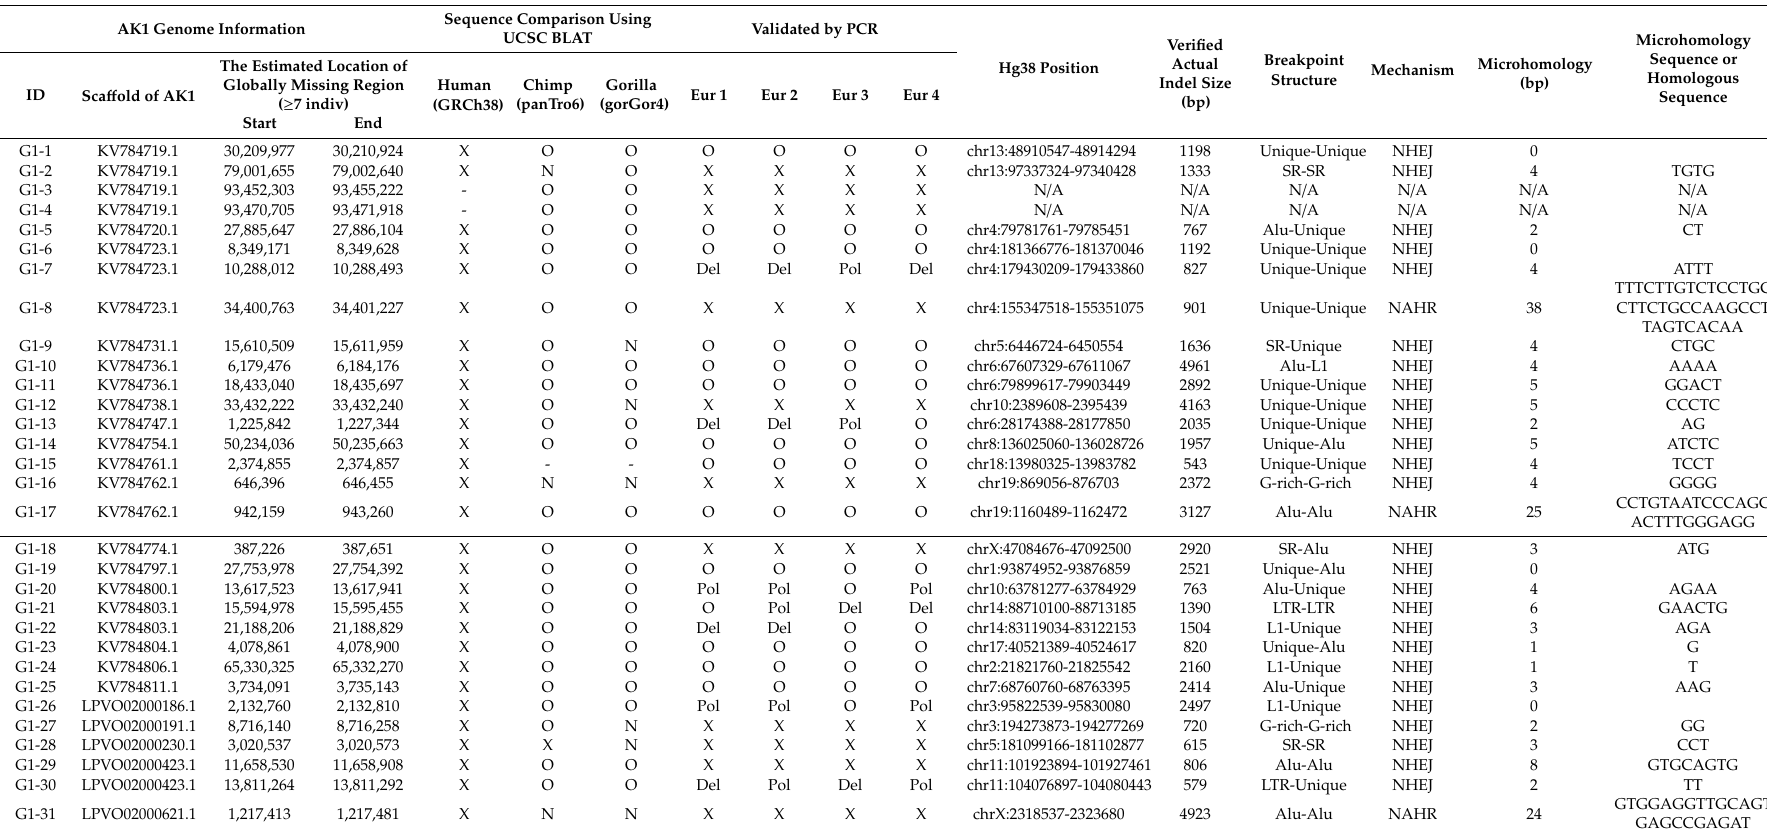
Table 4. Characteristics and verifications of the presence of the estimated globally missing regions on Group 1 sca ff olds. The common candidate regions globally missing with ± 2 kb of flanking sequences were searched and 20 of 31 globally missing regions (shared by ≥ 7 individuals) were verified by